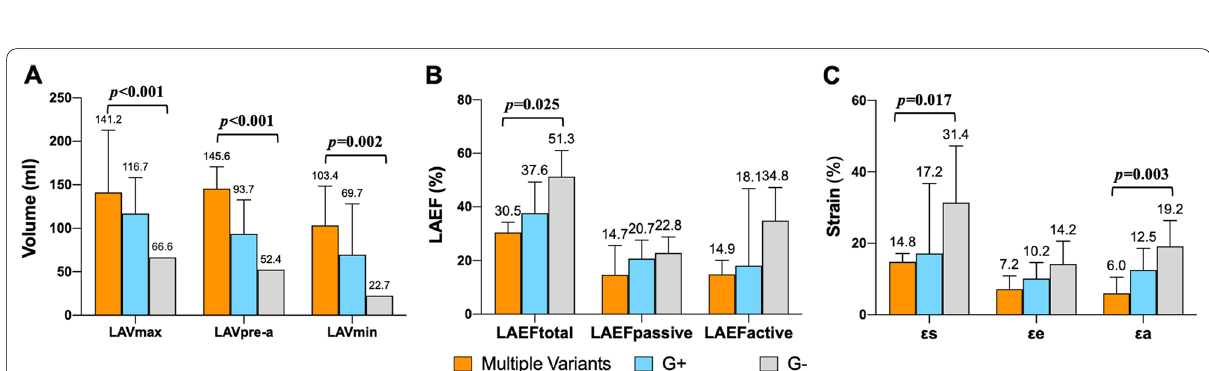
Fig. 3 Correlations among carriers of multiple variants, G group and G group in left atrial volume ( a ), left atrial emptying fraction ( b ), and left + − atrial longitudinal strain ( c ). p values for independent t test or Mann–Whitney U -test between parameters from carriers of multiple variants and G group. G genotype positive, G genotype negative, LAVmax maximal left atrial volume, LAVpre-a left atrial volume before LA contraction, LAVmin + − minimal left atrial volume, LAEF left atrial emptying fraction, εs total strain, εe passive strain, εa active